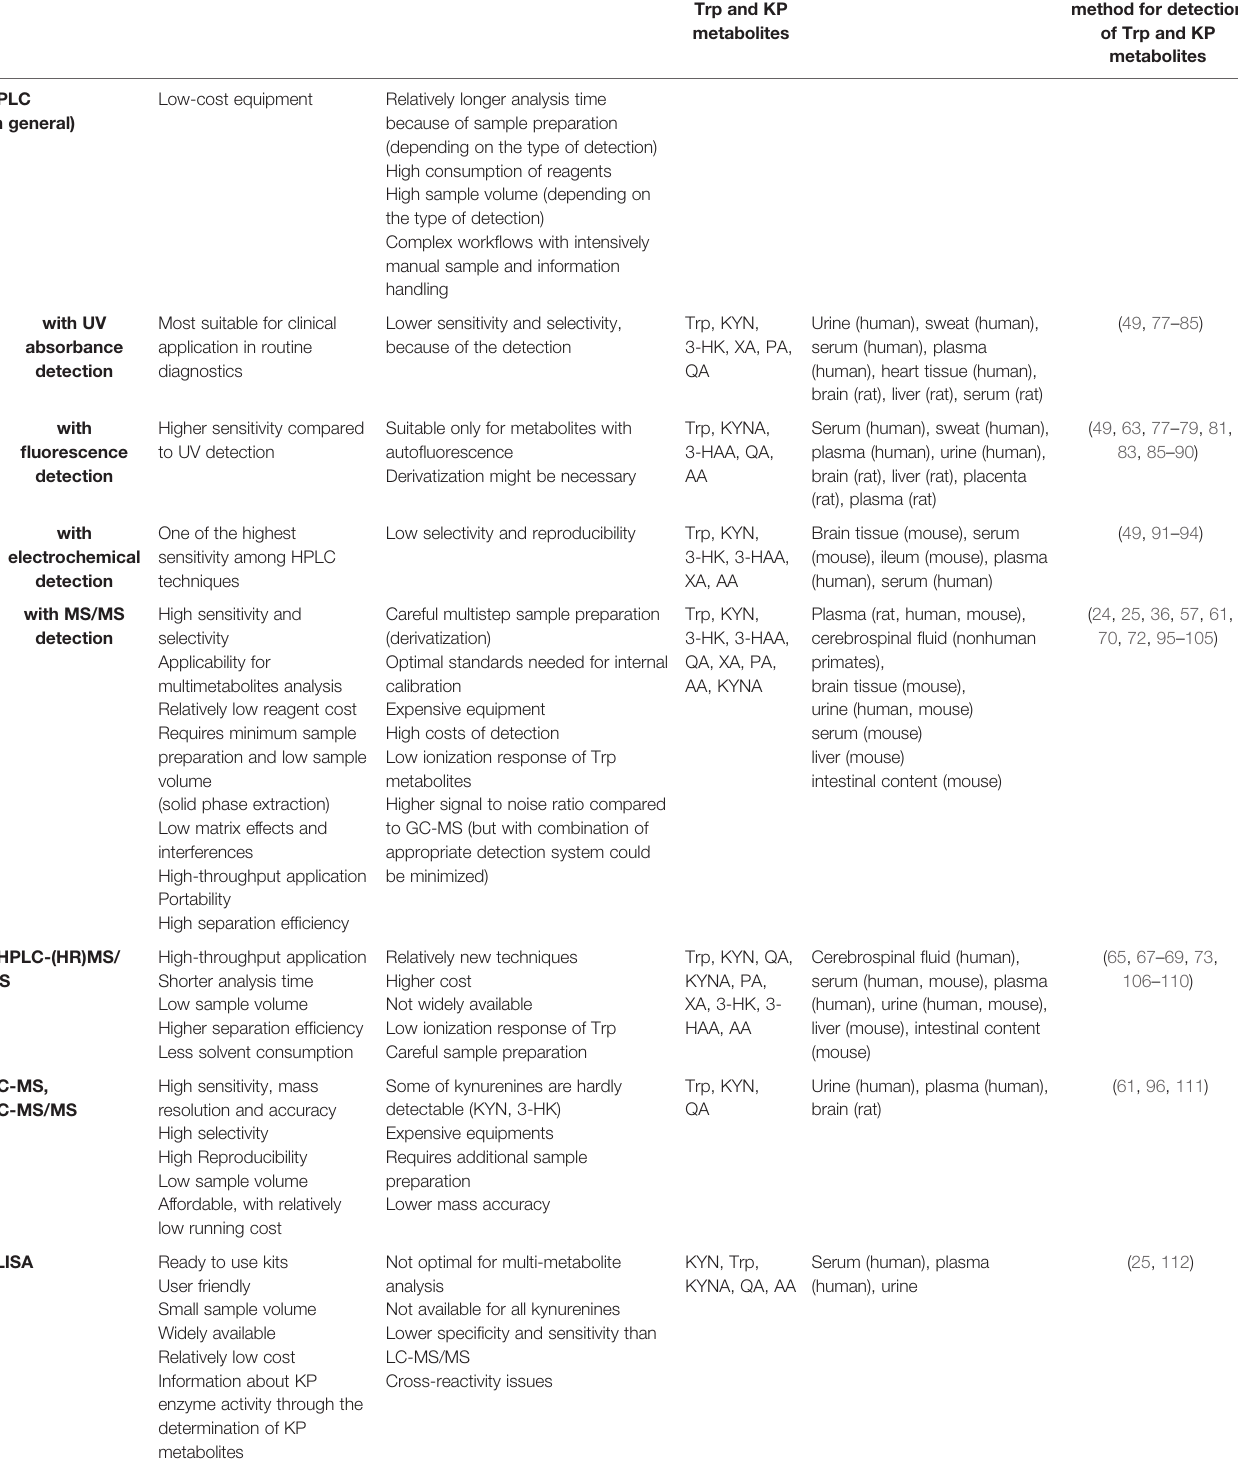
TABLE 2 | Detection possibilities of Trp and kynurenine pathway (KP) metabolites and their most important advantages and disadvantages. Detection